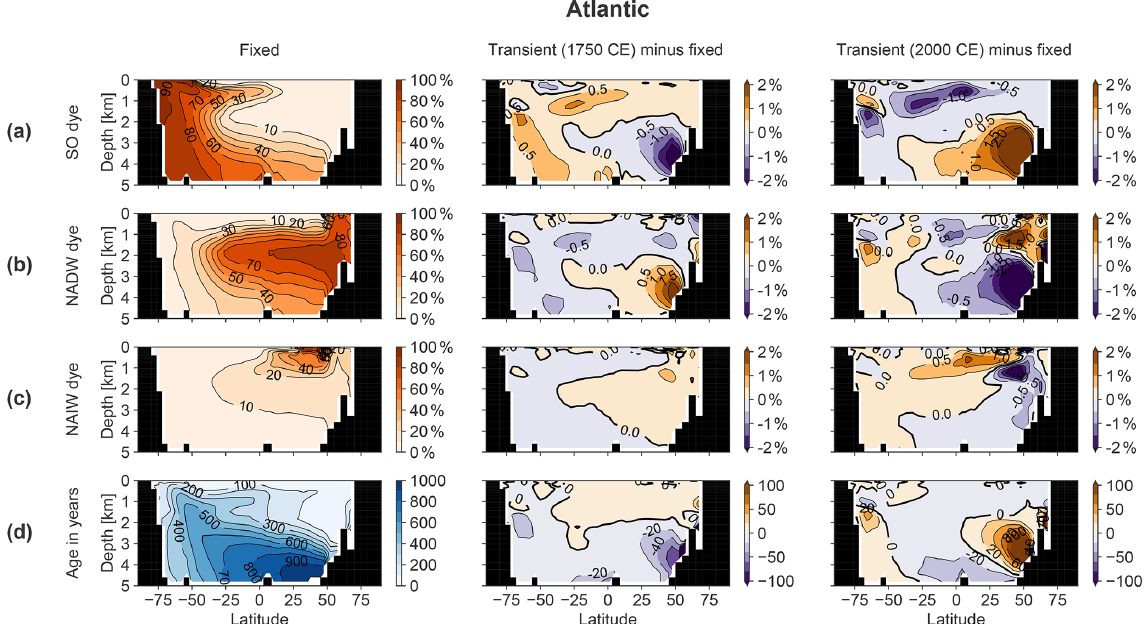
Figure 8. Zonally averaged meridional section of the Atlantic basin, including the SO sector, showing (a) Southern Ocean dye tracer, (b) North Atlantic Deep Water dye tracer, (c) North Atlantic Intermediate Water dye tracer and (d) ideal age. Columns show the fixed- circulation simulation (OcFIX) and the anomaly of transient (OcTRA) with respect to fixed dye tracer in 1750 (coldest time in LIA) and 2000CE. Units for dye are a fraction of initial dye concentration at the surface, in percent.